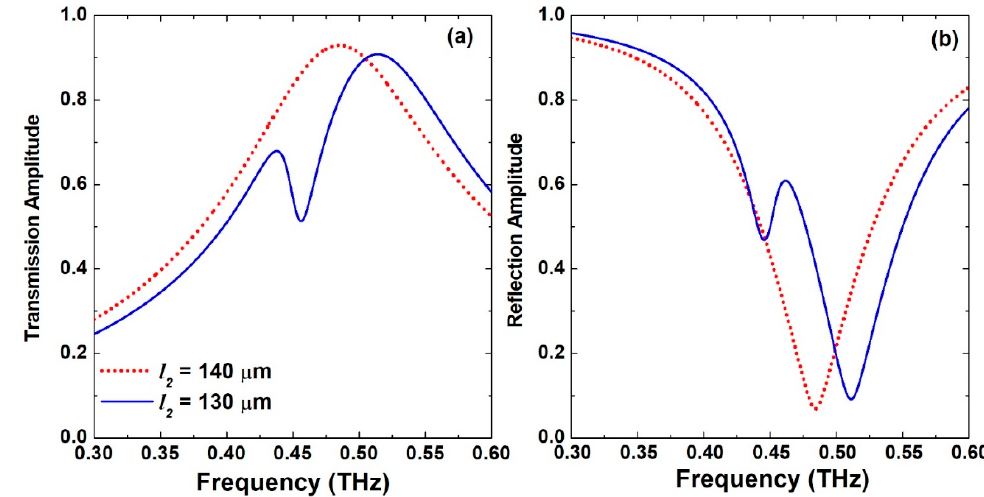
Figure 3. ( a ) Transmission and ( b ) reflection frequency response of the S-shaped complementary metasurface for the symmetric case when l 2 = 140 μ m and the asymmetric case when l 2 = 130 μ m.